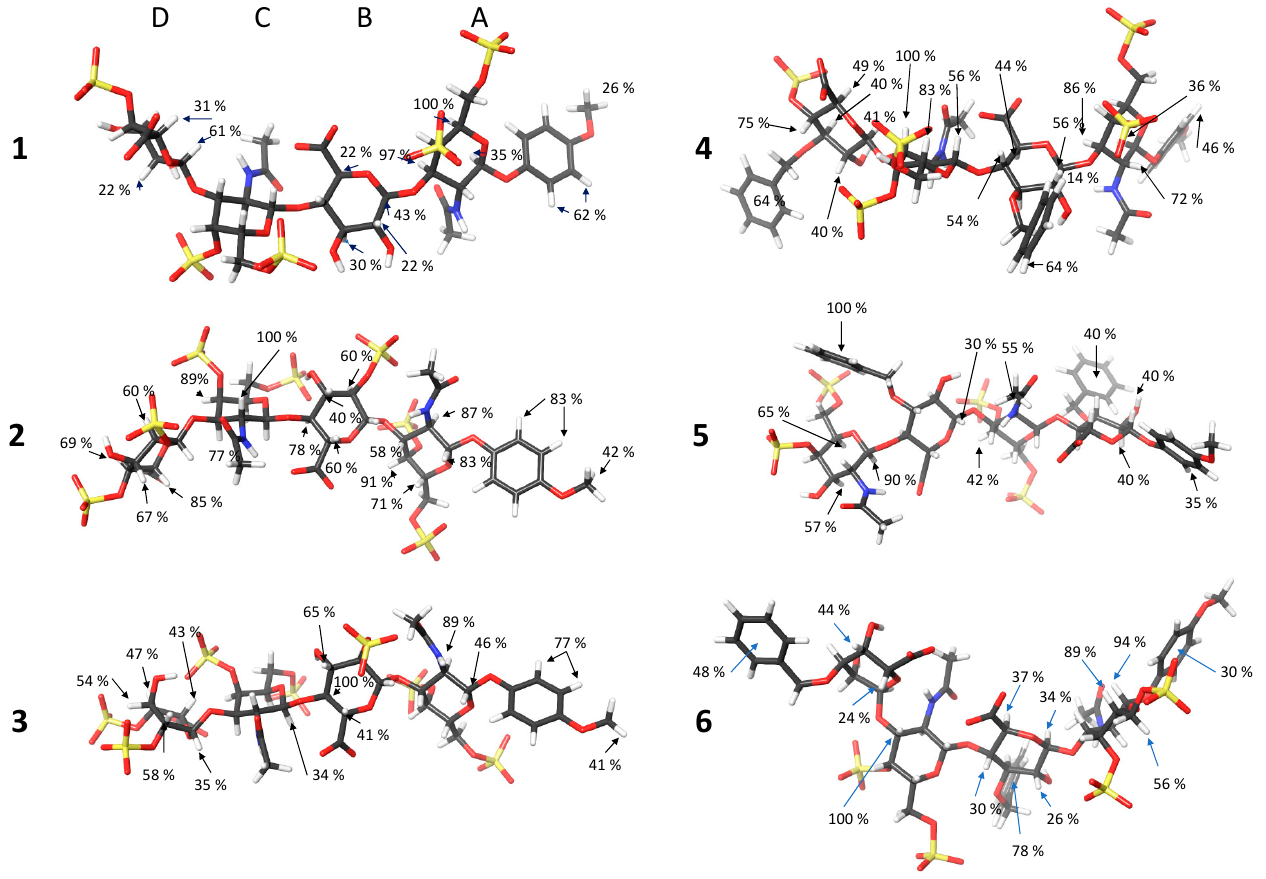
Figure 3. Relative STD 0 values for 1 – 6 into randomly taken structures along time-averaged restrained molecular dynamics representative of the global disposition of substituents along the main molecular axis. The p -MethoxyPhenyl group is always oriented towards the right side. Table 2. Relative and absolute STD 0 values for 1 – 6